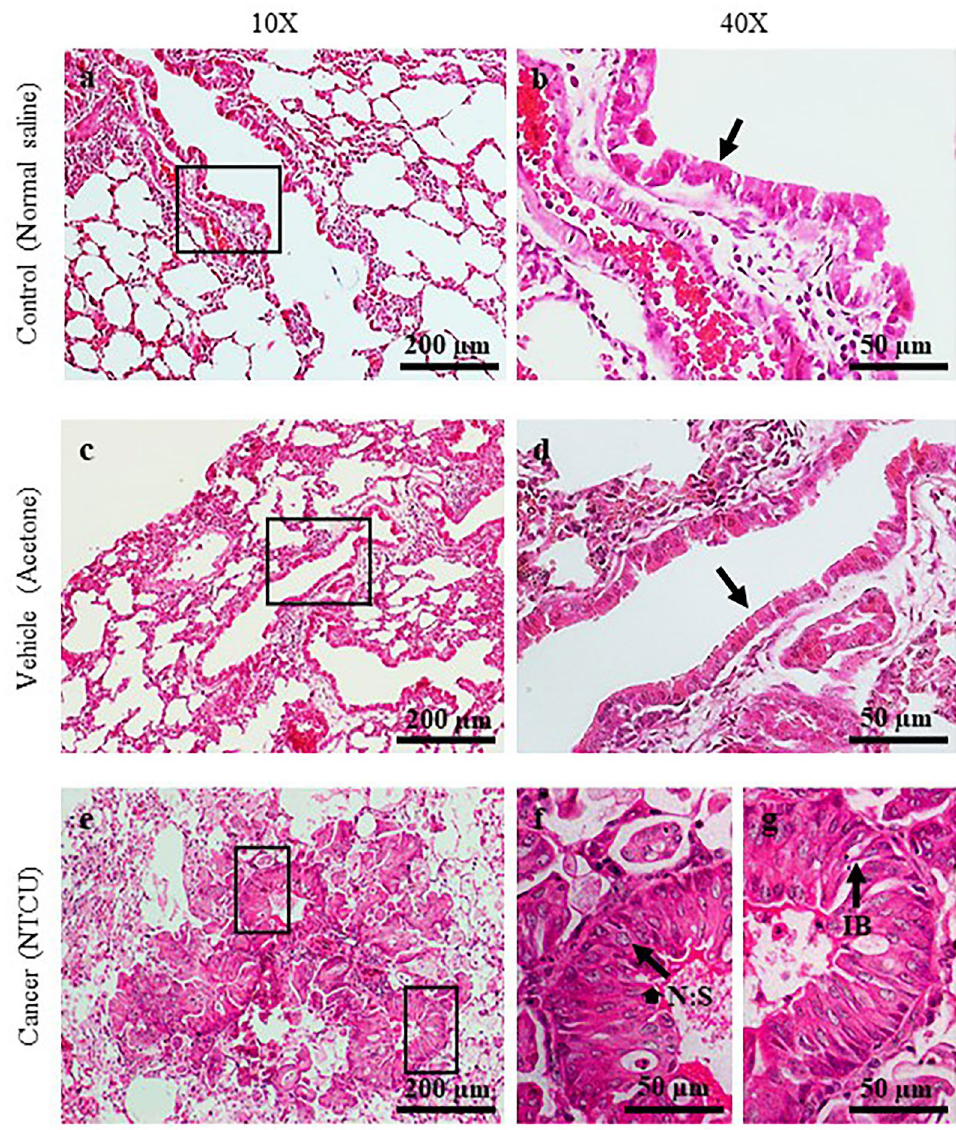
Figure 2. H&E Staining of the bronchial area after 30 weeks of treatment with normal saline ( a and b ), acetone ( c and d ), and NTCU ( e , f , and g ). Arrows in ( b ) and ( d ) show normal bronchial epithelial cells. Arrow in f shows cancer cells with a high nuclear to cytoplasm (N:S) ratio. Arrow in g shows intracellular bridge (IB).